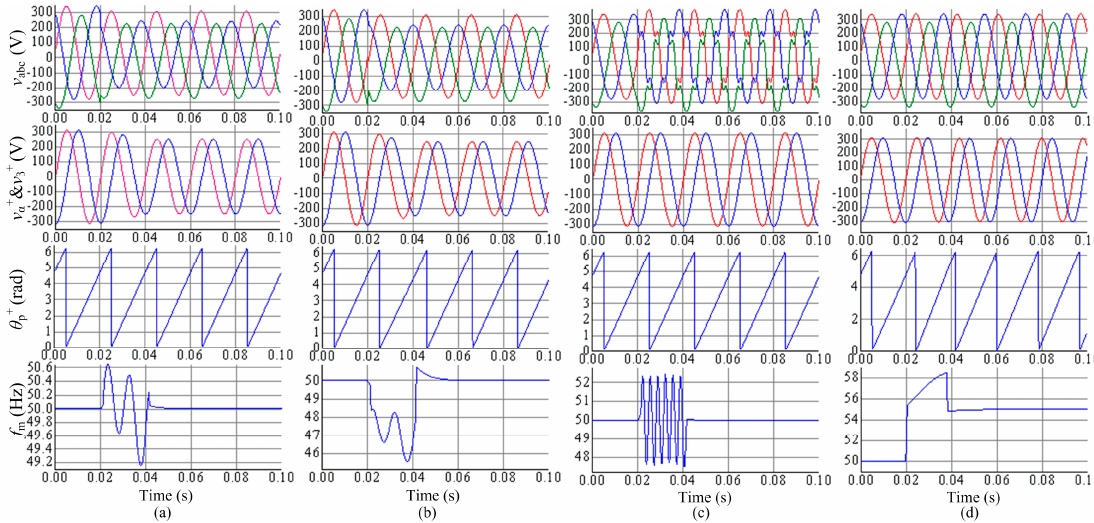
Figure 12. The experimental results under conditions I–IV. ( a ) Voltage sag; ( b ) Phase jump; ( c ) Harmonics; ( d ) Step-changed frequency. Energies 2017 , 10 , 280